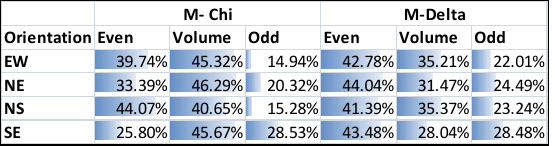
Table 1: Percentage of scattering powers of different orientation of buildings